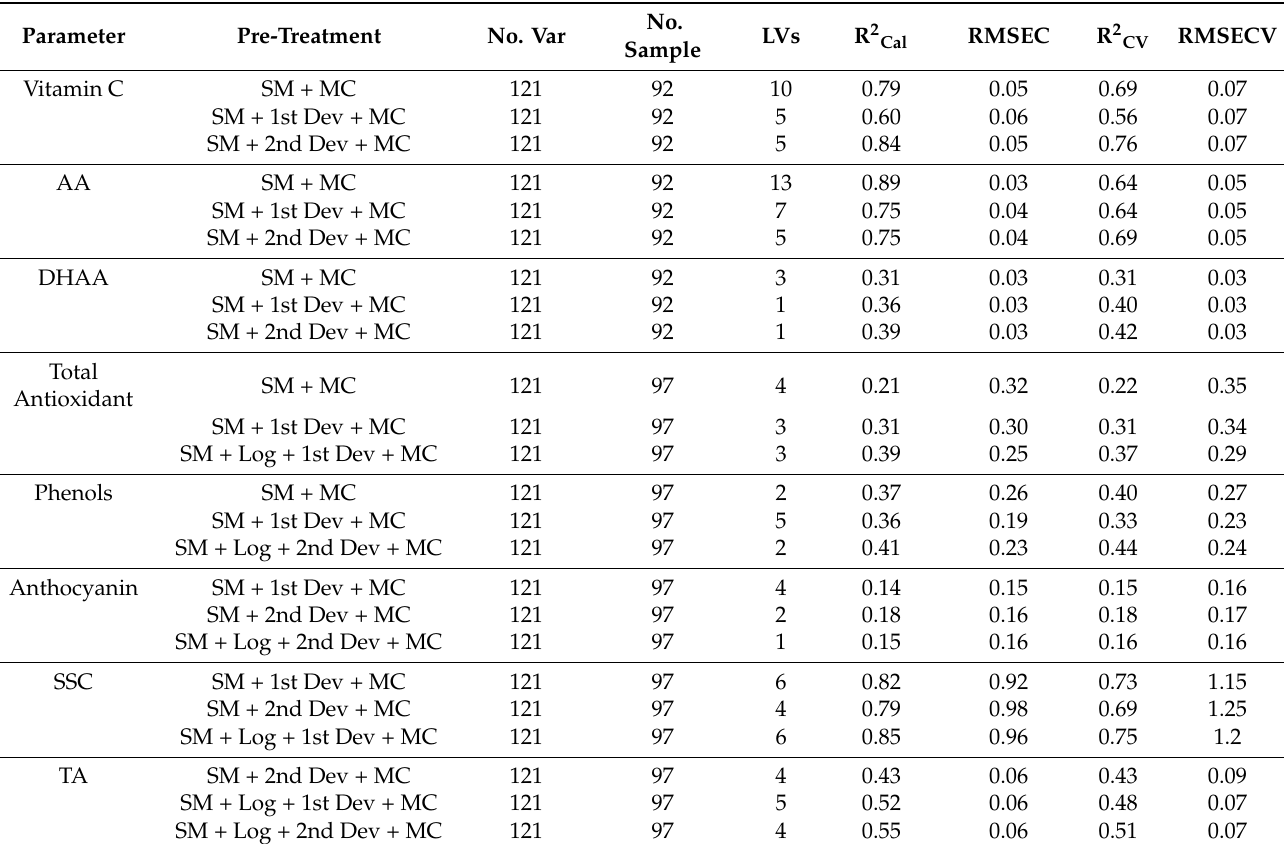
Table 2. Calibration statistics for the PLSR models of the internal constituents of fresh goji berries (SM = Smoothing,